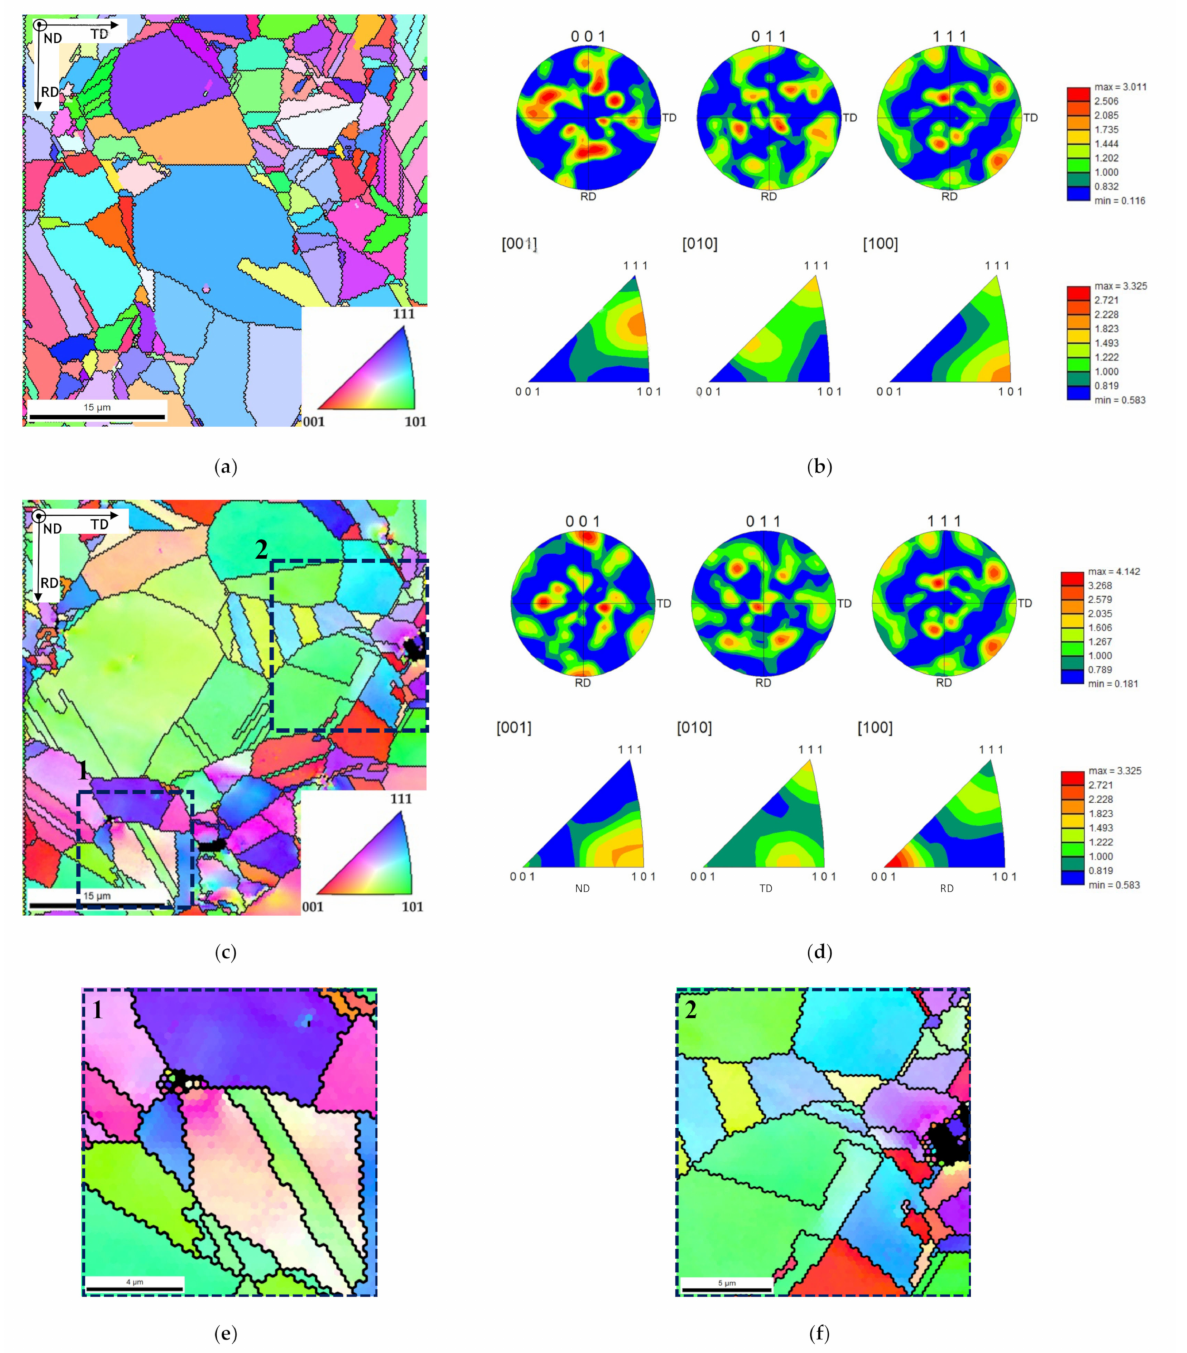
Figure 5. IPF maps and IPF and PF charts of samples produced by ball milling for 60 min: ( a , b ) Ni; ( c , d ) Ni-CNT; and ( e , f ) high magnification of regions marked as 1 and 2 areas in ( c